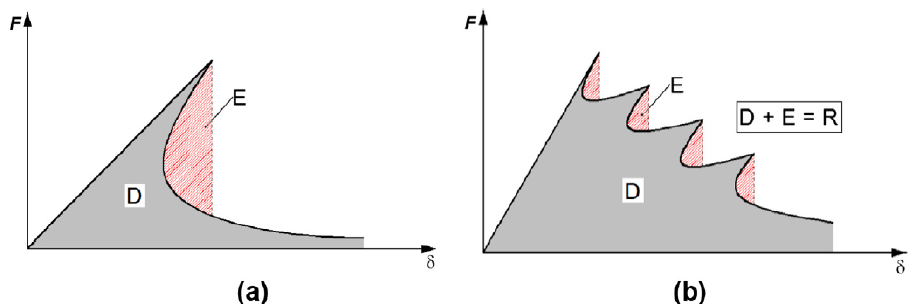
Figure 2. Load–displacement curves representing ( a ) a catastrophic failure (single snap ‐ back) and ( b ) a global softening behavior perturbed by multiple local instabilities (snap ‐ backs). The grey areas identify the dissipated energy, D , whereas the red (dashed) ones represent the emitted energy, E . The total released energy, R , is the summation of the two previous areas: D + E = R . Reproduced with permission from [7], Elsevier, 2016.